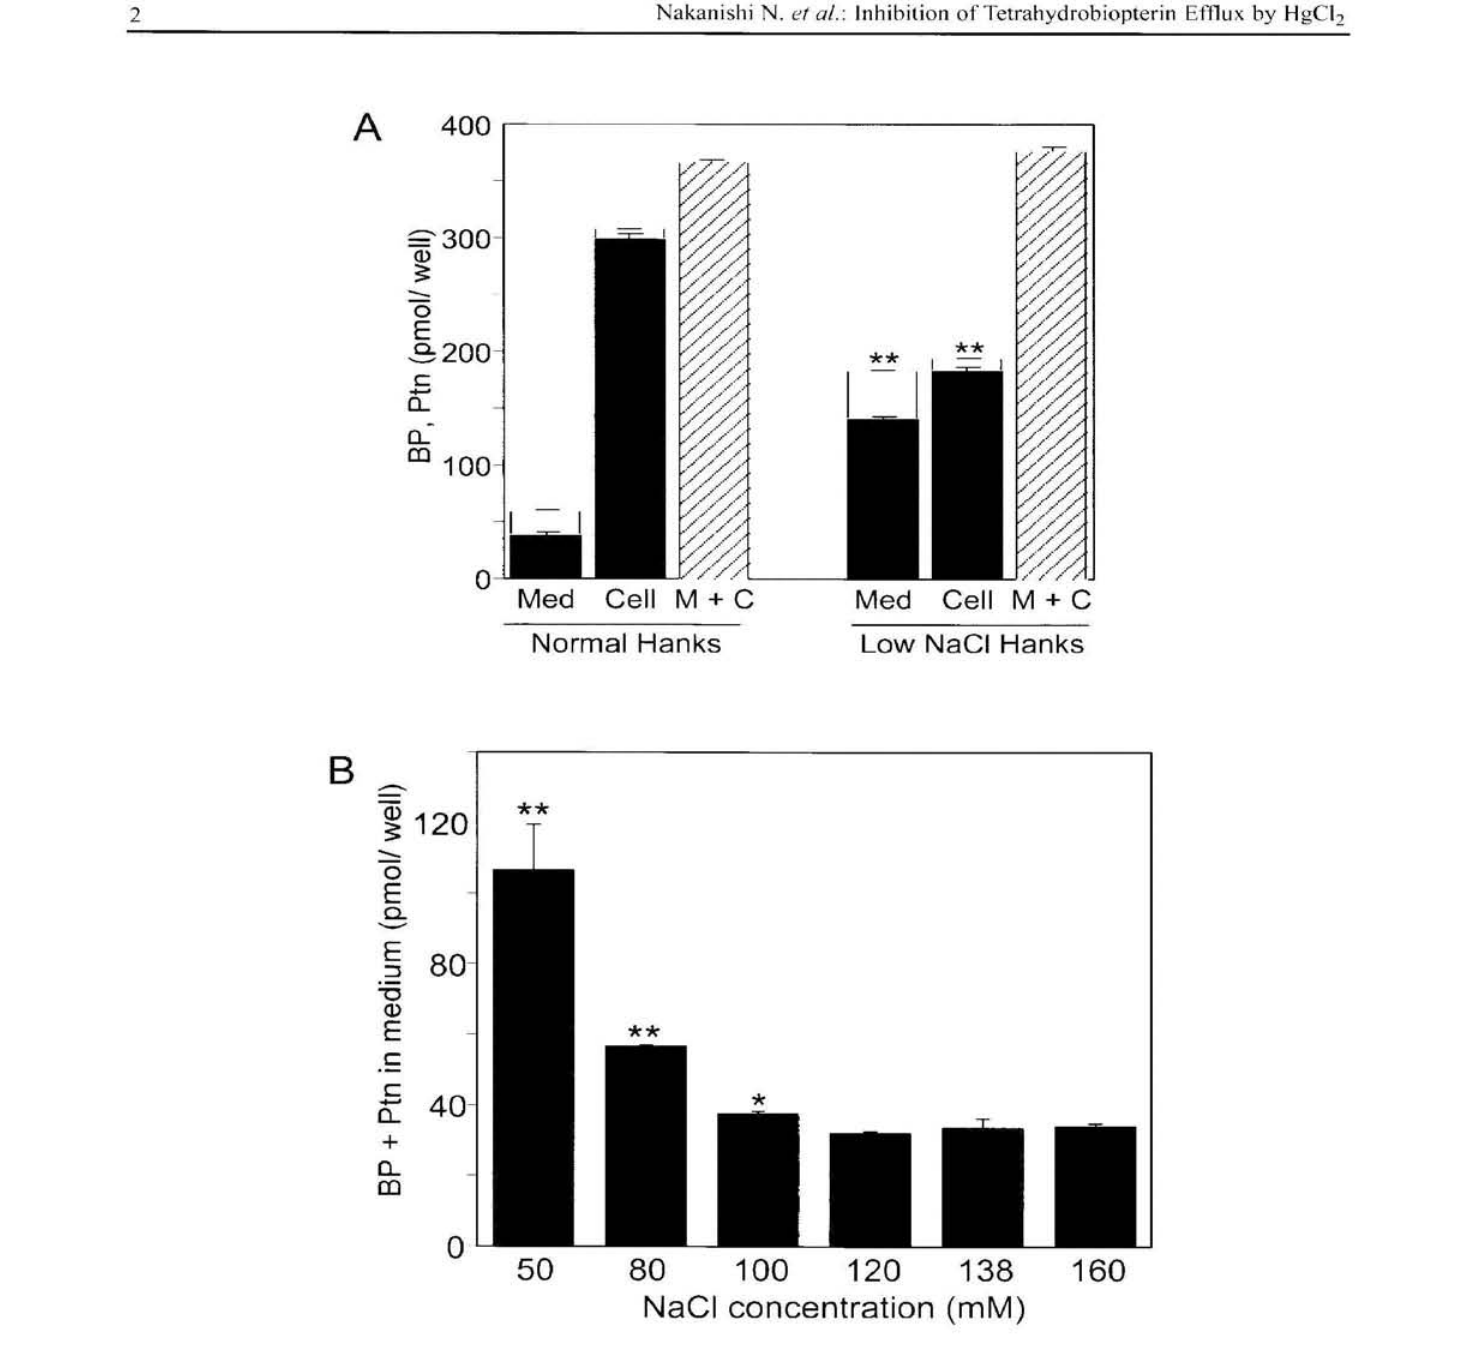
Figure I. BH 4 outward flow from PC 12 cells in Hanks medium of various NaCI concentrations. A: PC 12 cells in a 12-well plate were incubated in normal Hanks medium or low NaCl-Hanks medium (40 mM NaCI) for 10 min in a C0 2 incubator at 37°C and then biopterin (BP) and pterin (Ptn) contents in the medium and cells were measured as described in Materials and Methods, (closed bar: BP open bar: Ptn, hatched bar: sum amount of medium [BP+Pln] plus cell [BP+Ptn]). Values are the means ± SD (n=4). **BH 4 outward flow ([BP+Ptn] con- tent in the medium) and cellular [BP+Ptn] content with the low NaCl-Hanks medium were different form those with the normal Hanks medium at p<0.001. B: Effect of NaCI concentrations in Hanks medium on the BH 4 out- ward flow ([BP+Ptn] content in the medium). BH 4 outward flow from the cells was analyzed in the normal Hanks medium (138 mM NaCI) and Hanks medium of various NaCI concentrations for 20 min in a C 0 2 incubator at 37°C. Values are the means + SD (n=4). *p<0.05 and **p<0.001 vs. the value obtained with normal Hanks me- dium (138 mM NaCI).